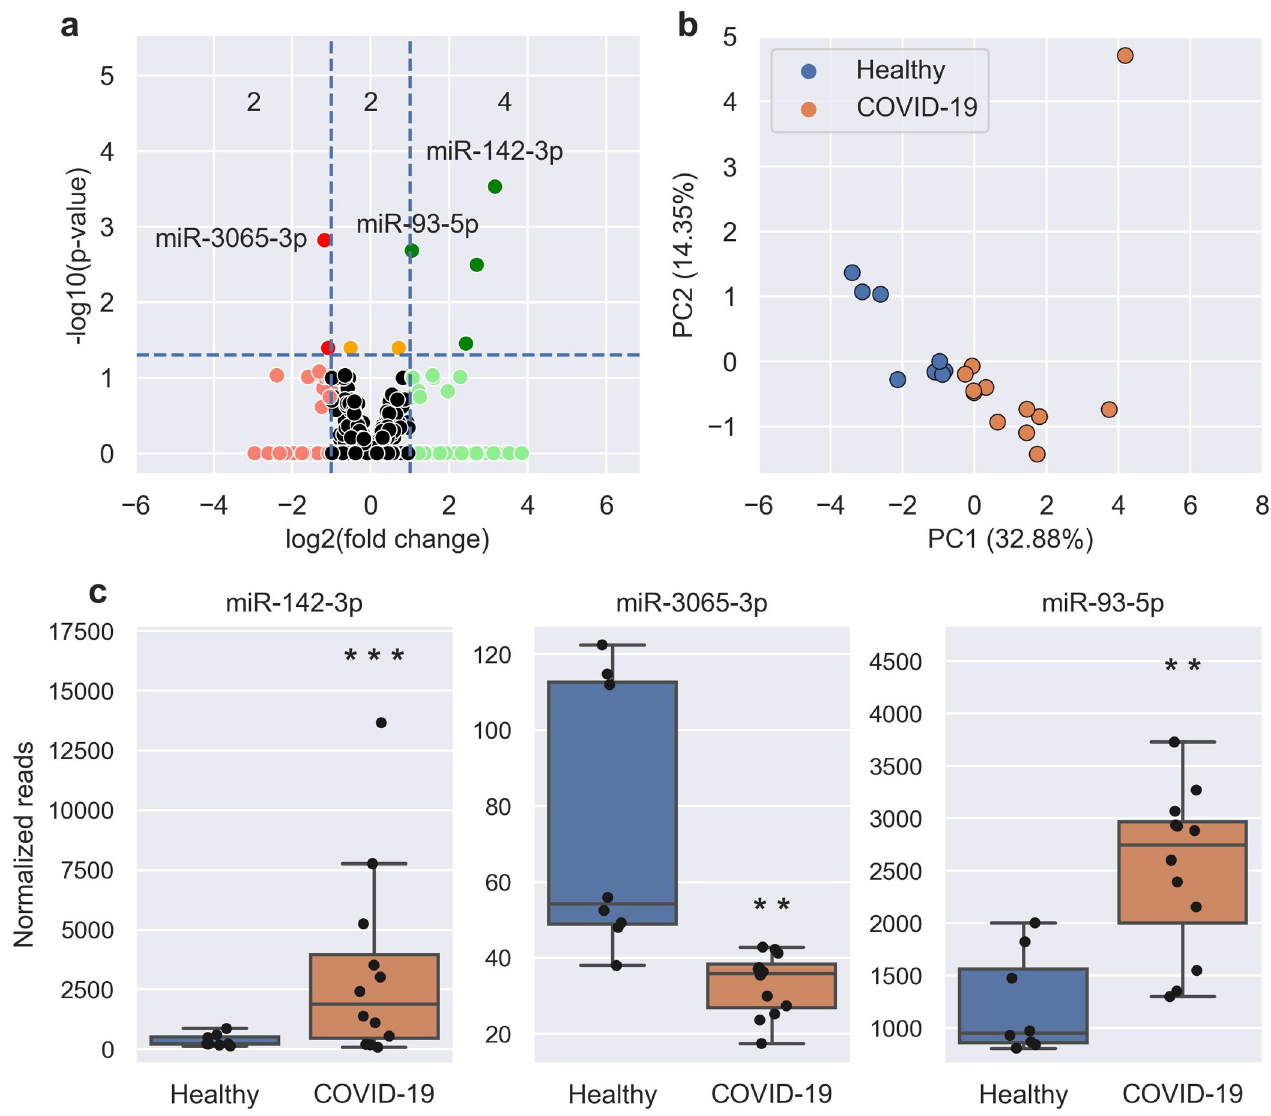
Fig 2. SARS-CoV-2 induces significant chances in the miRNA profile from patient nasal swabs. A, Volcano plot showing the increased (green) and decreased (red) DE miRNAs in COVID-19 patients when compared to healthy controls. Horizontal dotted line is the p-value cut-off (False Discovery Rate, FDR < 0.05) and the vertical lines are the fold change cut-off ( > 2 FC). Orange miRNAs are statistically significant but are not > 2 FC. The number of statistically significant miRNAs (adjusted P-value < 0.05) in each section are shown: < -1 Log2 FC (2 miRNAs), between –1 and 1 Log2 FC (2 miRNAs), and > 1 Log2 FC (4 miRNAs). The most up-regulated, down-regulated, and statistically significant miRNAs have been labelled. B, PCA plot showing the separation of healthy (blue) and COVID-19 (orange) samples using the 8 DE miRNAs. C, Boxplots of select miRNAs in healthy (blue) and COVID-19 (orange) samples. Boxes are the 25 th - 75 th percentile, line is the median, and whiskers are 1.5x IQR. �� p-value < 0.01, ��� p-value <